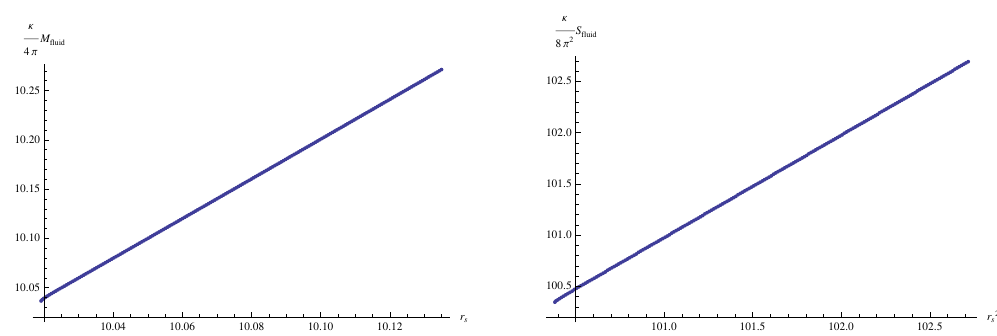
Figure 13 . The (cid:13)uid’s contribution to the Komar mass M (cid:13)uid and the entropy S (cid:13)uid for a 0 = 10 and (cid:11) = 0 :